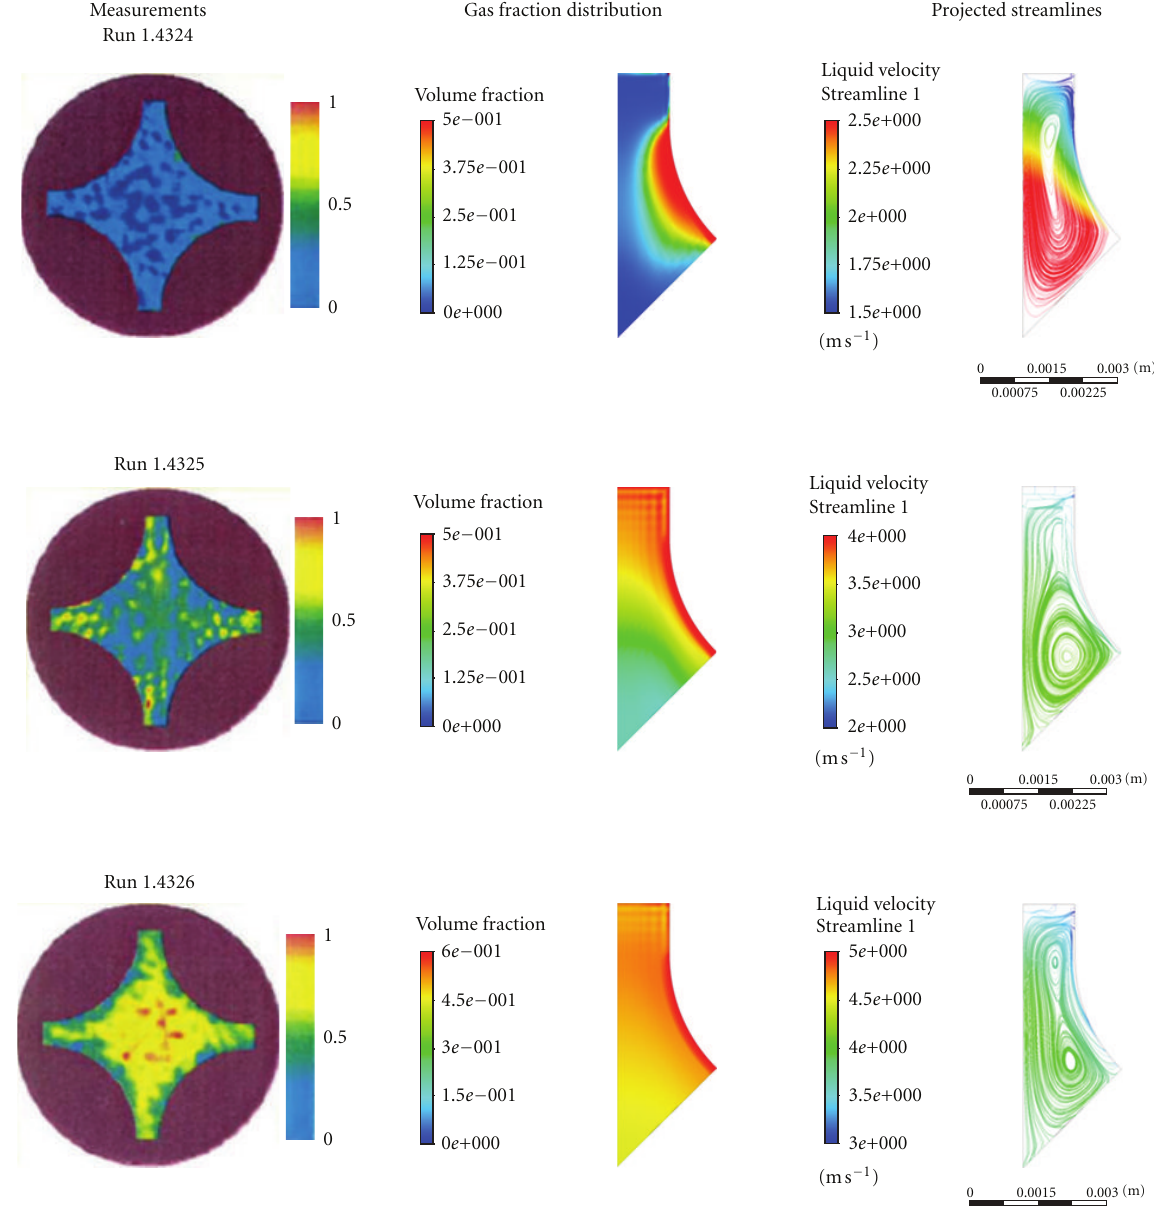
Figure 11: Tendencies of gas fraction distribution for the runs 1.4324, 1.4325, and